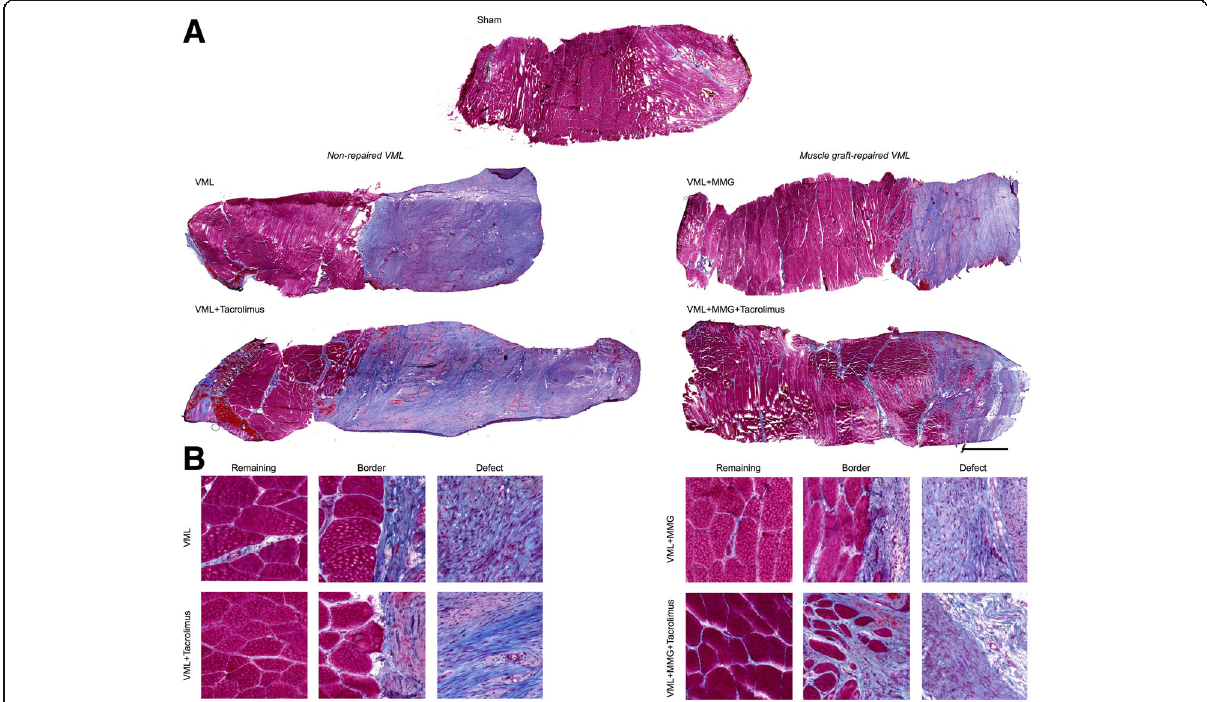
Fig. 1 Representative histologic micrographs of Masson ’ s Trichrome stained (connective tissue is blue; nuclei are purple; skeletal muscle fibers are red) porcine peroneous tertius (PT) muscle following VML injury and repair. While all PT muscles indicate gross fibrosis following VML injury, only the muscle graft-repaired displayed areas of likely regenerated fibers. There were no apparent differences due to treatment with tacrolimus. ( a) Each sam- ple represents a full thickness sample through the muscle. Scale bar is 2 mm; all images are at the same magnification. (b) Representative inserts from the remaining muscle, border, and defect area of the samples are displayed. Scale bar is 100 μ m; all images are at the same magnification